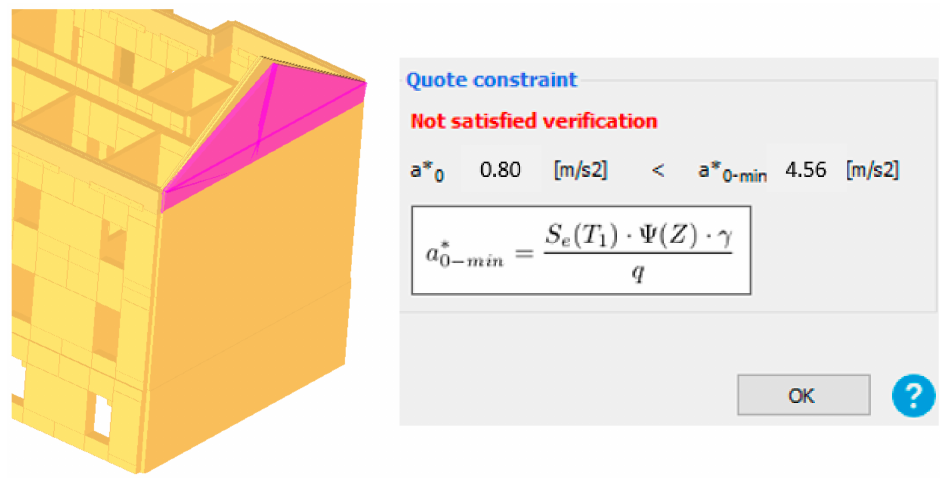
Figure 22. Local mechanism LM1 (Southern gable wall).